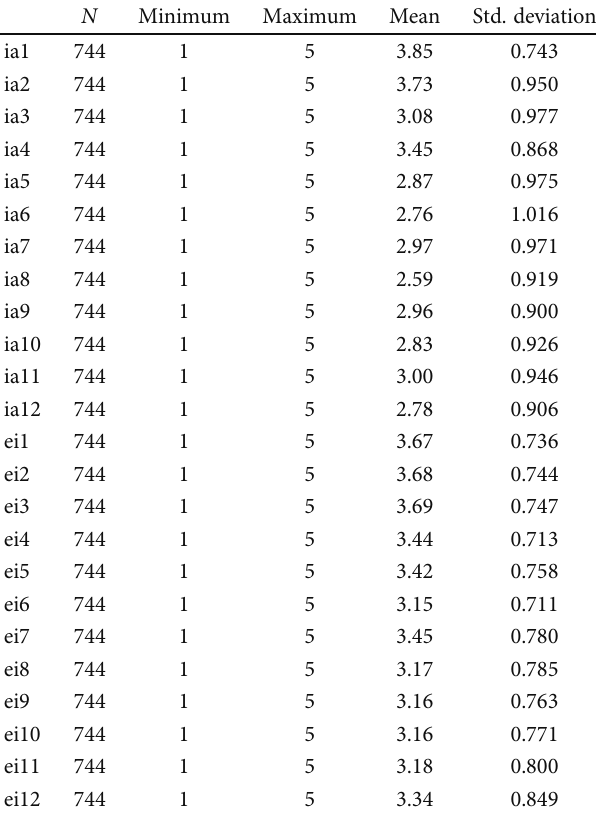
Table 1: Descriptive